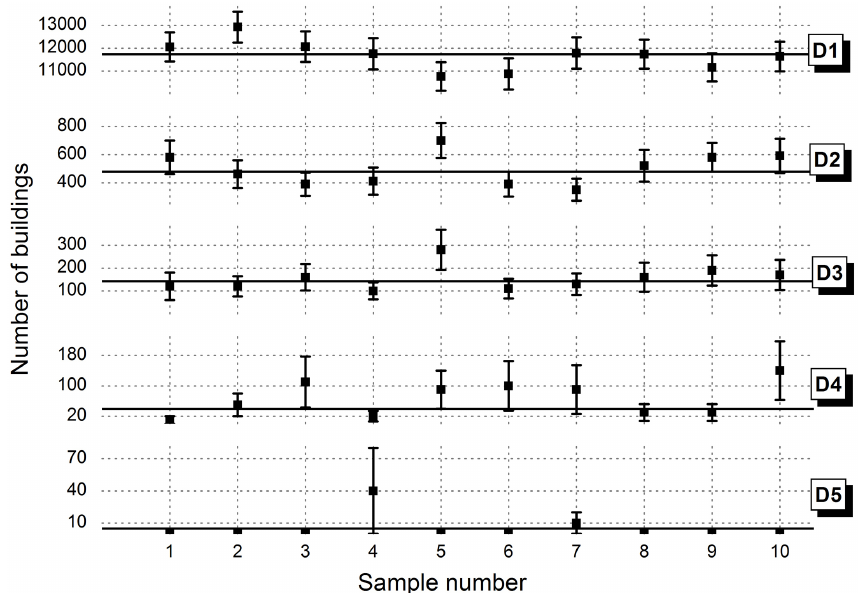
Figure A2. Number of buildings for each damage level from D1 to D5 for each of the 10 random, independent samples of cells (each containing 243 cells). The horizontal lines in each subplot correspond to the value reported in Table 6 (last row) and refer to the full set of 2433 cells. Data refer to the mean-sea-level